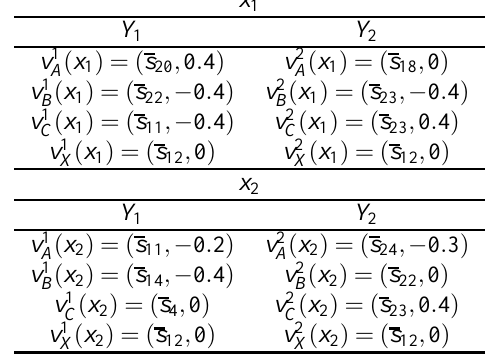
Table 7. Reviewers’ collective criteria values for each employee in the original term